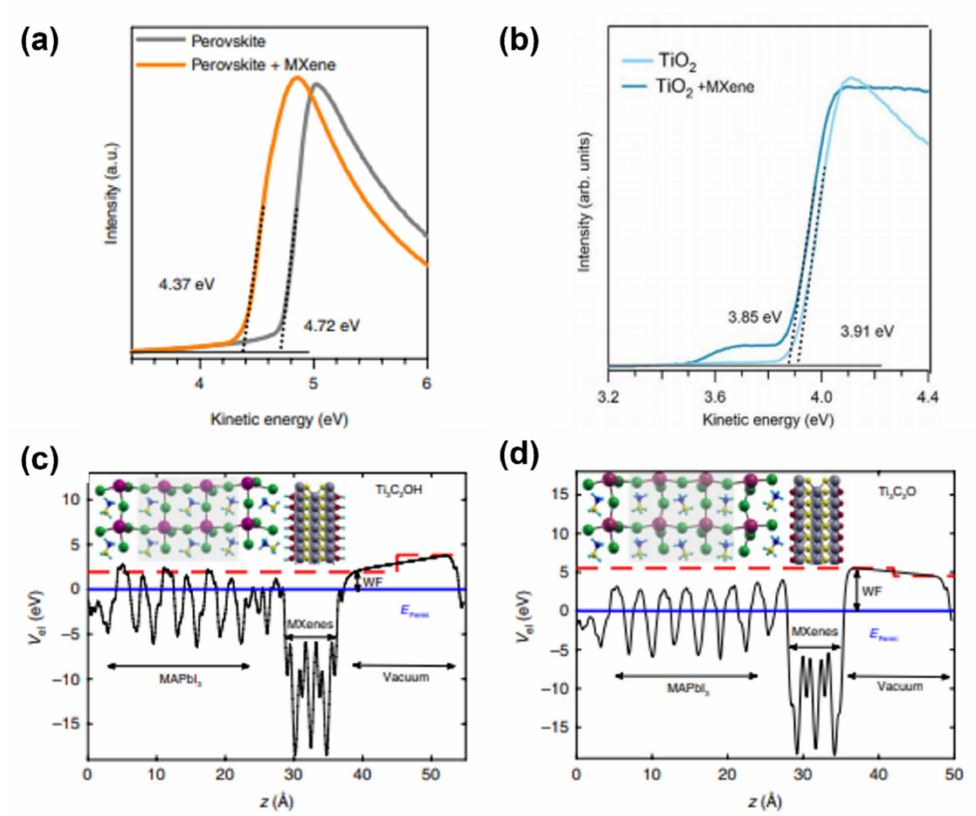
Figure 7. UPS spectra of ( a ) MAPbI 3 and ( b ) TiO 2 doped with Mxenes. Results of DFT calculations concerning the electrostatic potential of planes perpendicular to the ( c ) MAPbI 3 /Ti 3 C 2 (OH) 2 and ( d ) MAPbI 3 /Ti 3 C 2 O 2 interface. Data taken from ref. [90]. Copyright Springer